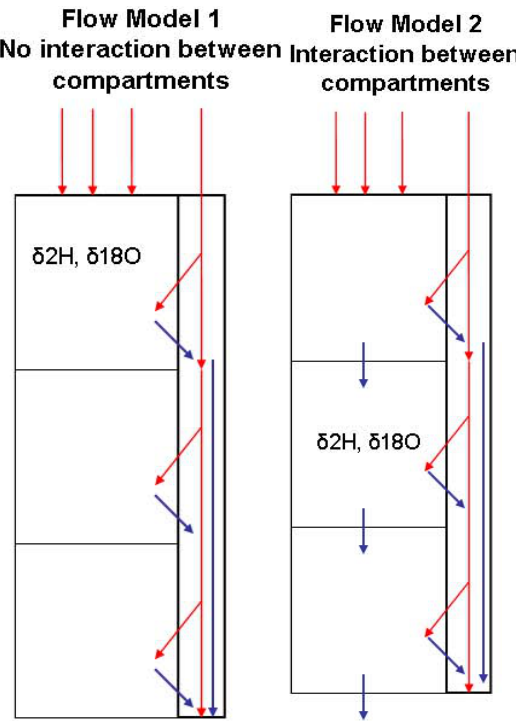
Fig. 1. Perceptual flow models for interaction of macropores and soil matrix compartments. Red arrows denote for the irrigation wa- ter, blue arrows denote for soil water. The boxes represent soil lay- ers, while the continuous box represents a preferential flow